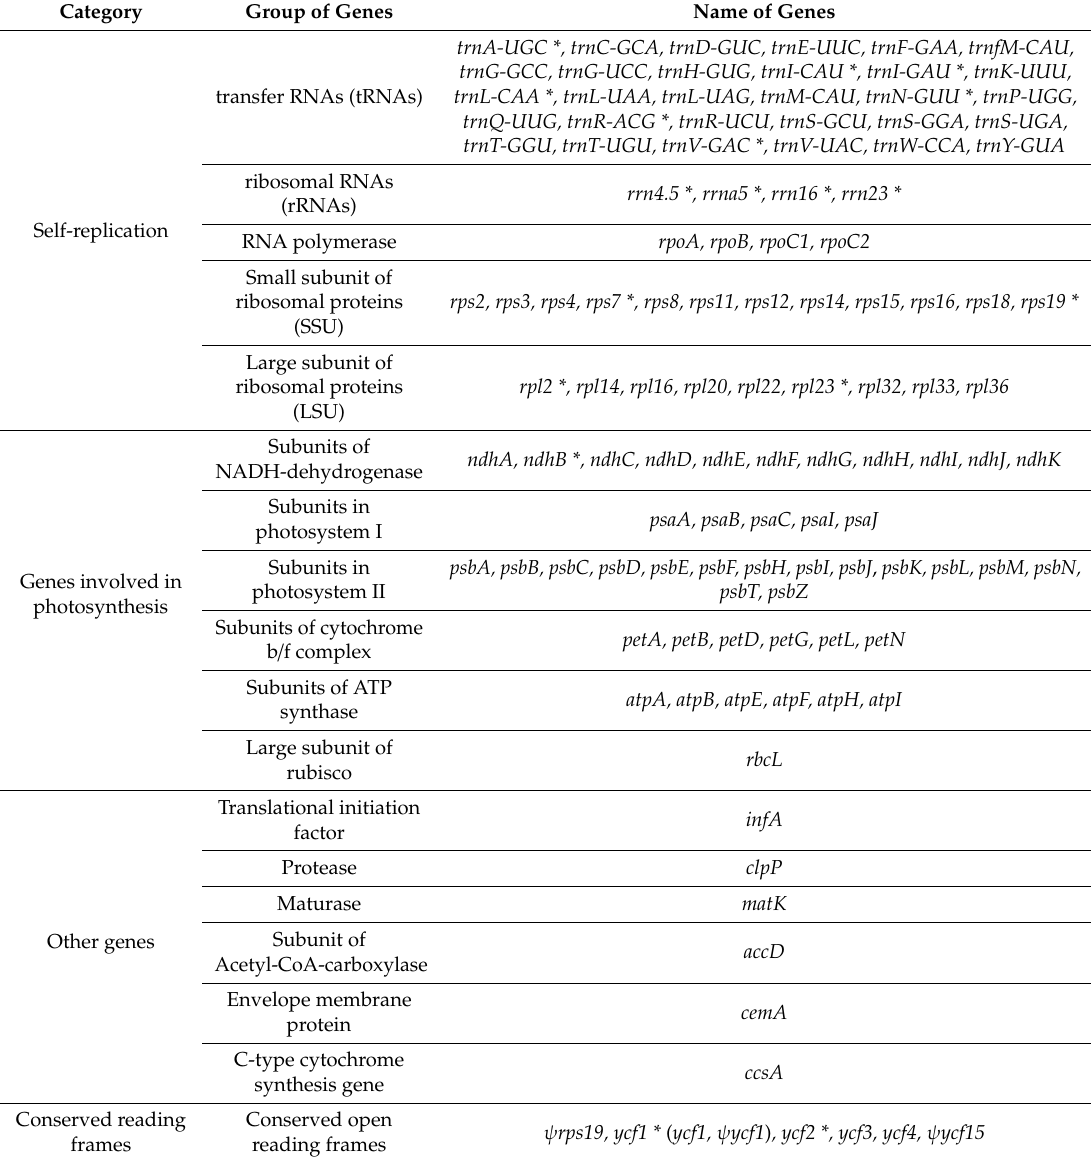
Table 2. List of genes encoded in the ten Hansenia , Haplosphaera and Sinodielsia plastid